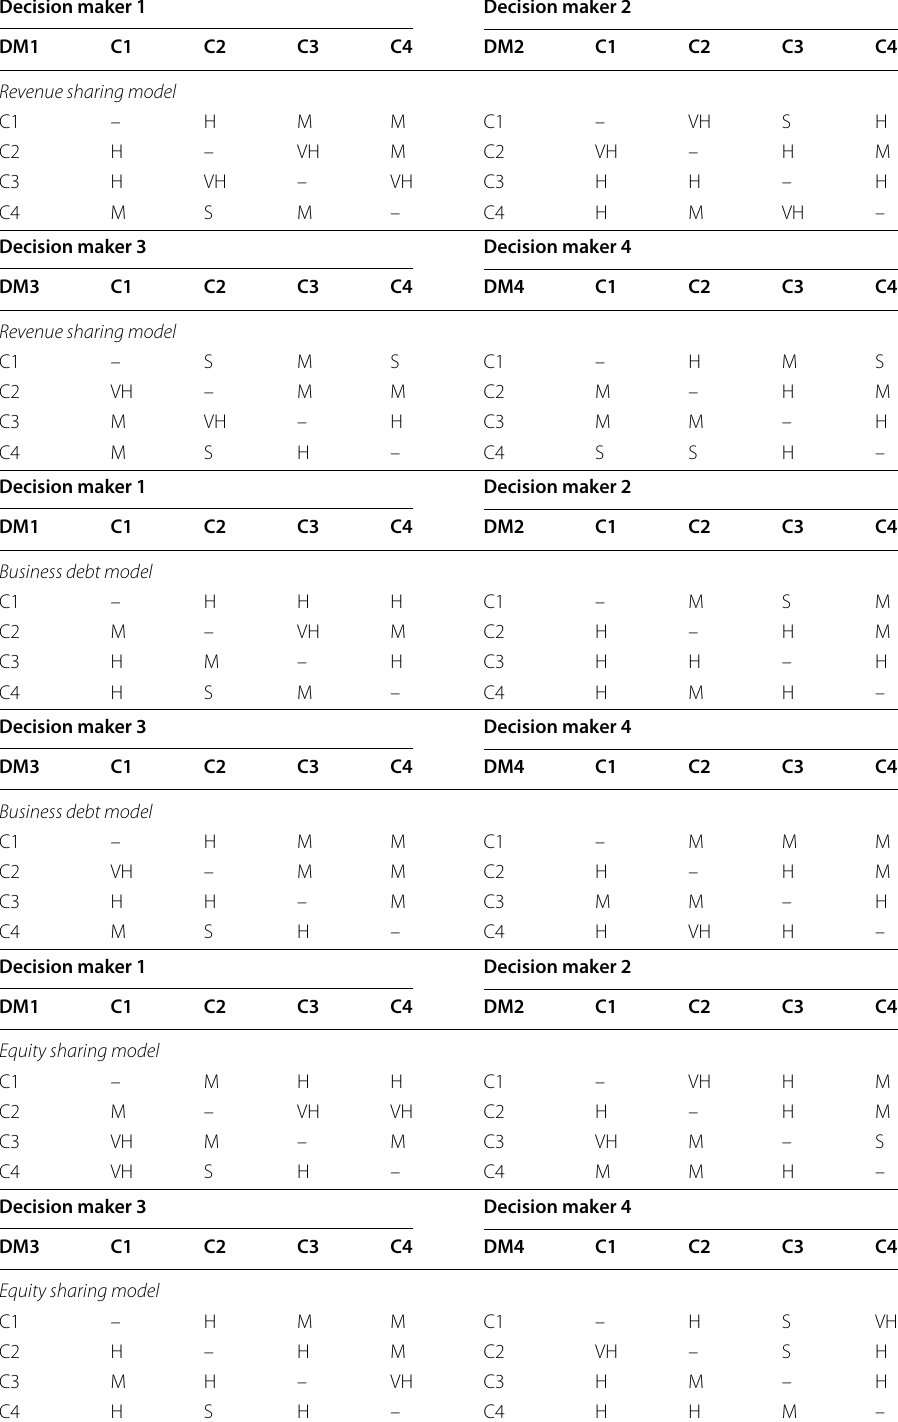
Table 4 Linguistic evaluations for fintech-based financing alternatives Decision maker